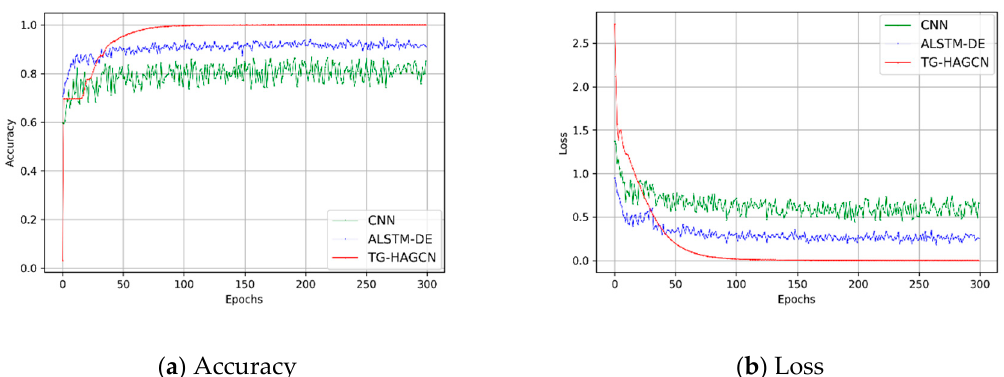
Figure 4. Curves of ( a ) accuracy ( b ) loss of different models.